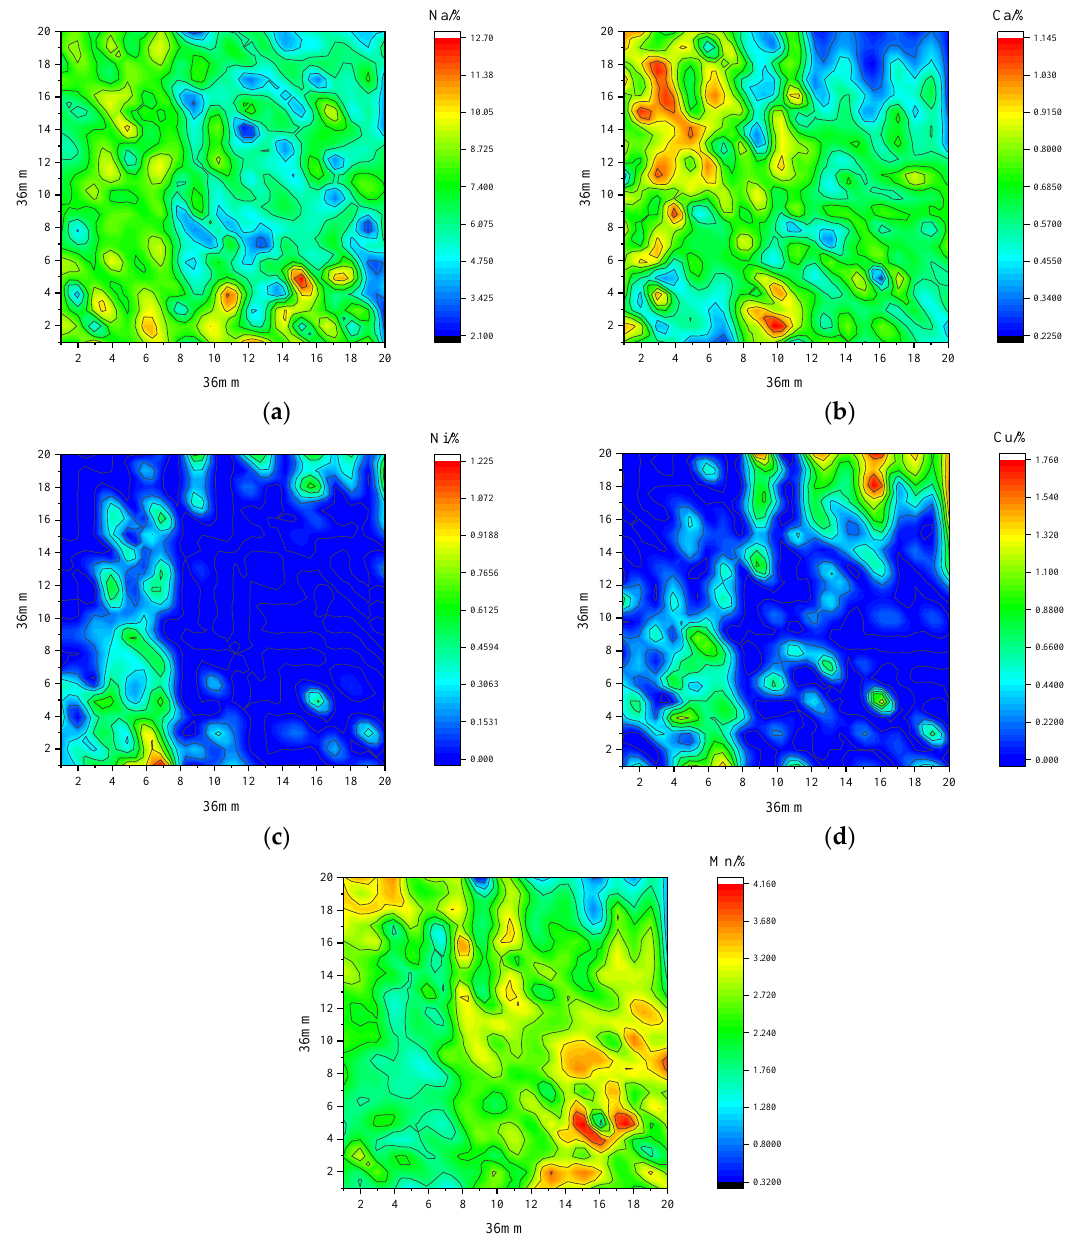
Figure 10. Elemental mapping produced with the model using PLSR, where ( a – e ) are Na, Ca, Ni, Cu and and Mn.